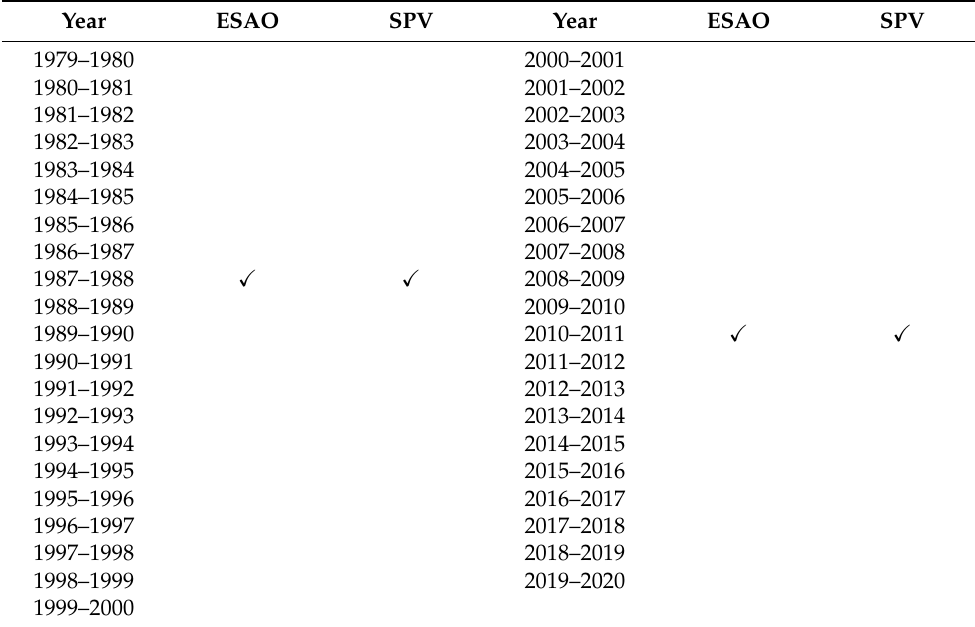
Table 1. Simultaneous occurrence of the easterly phase of the SAO (ESAO) and the strong polar vortex (SPV) from 1979 to